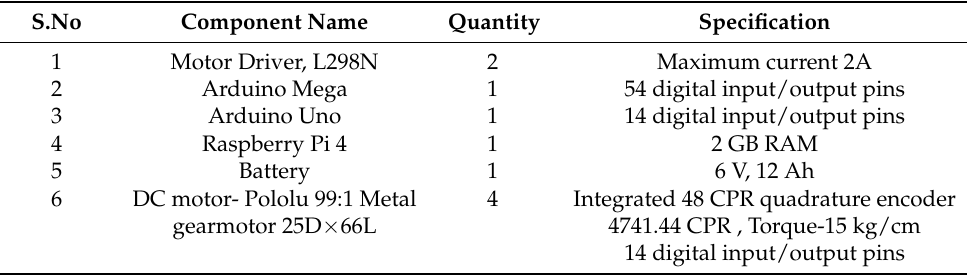
Table 3. Details of electronics part of mobile